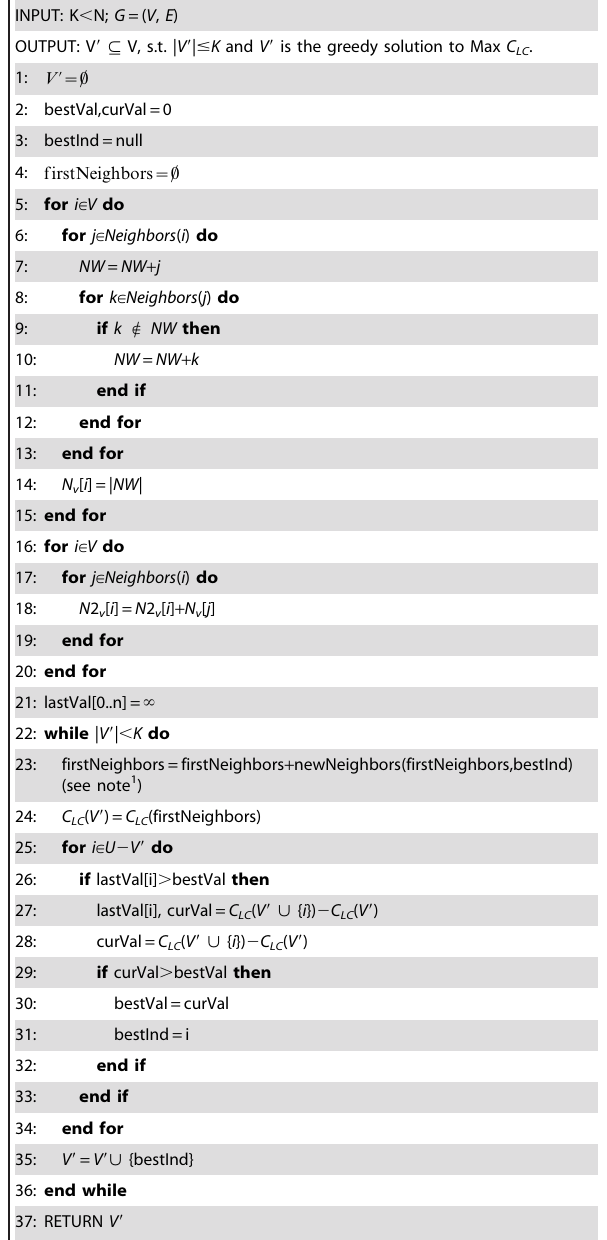
Algorithm: GREEDY- C LC